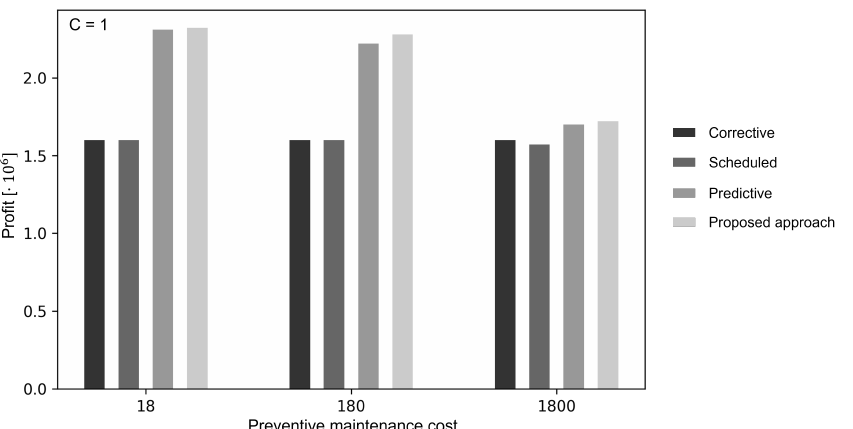
Figure 11. Performance of the considered policies in terms of average profit over 100 test episodes, considering C = 1 maintenance crew and different values of WTs failure rate λ f , with